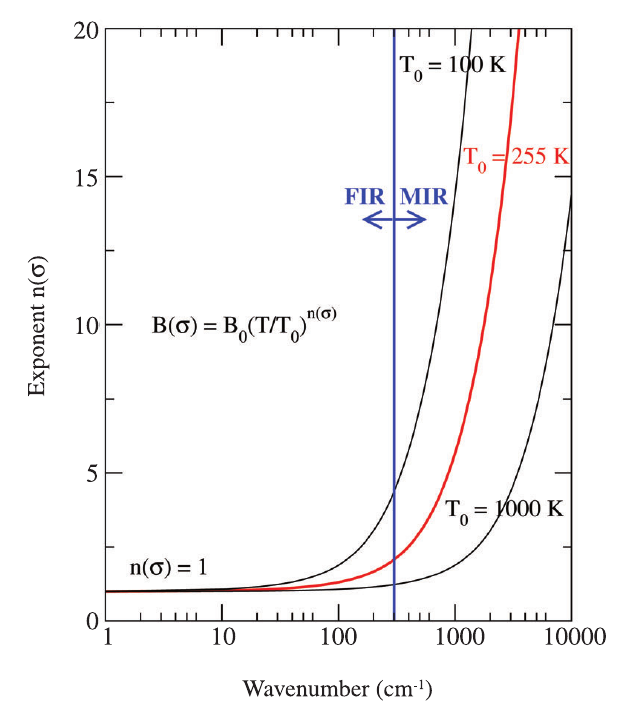
Fig. 2. Temperature dependence of the Planck